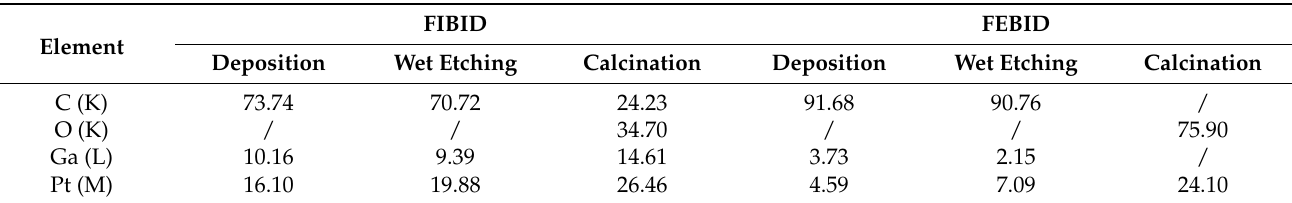
Table 1. The atomic concentrations of the dual beam-induced resultants.